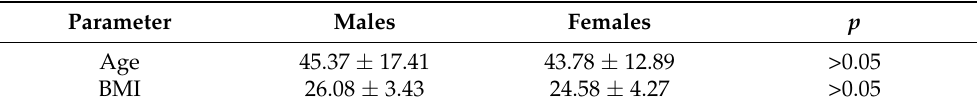
Table 3. Multifactorial logistic regression analysis.